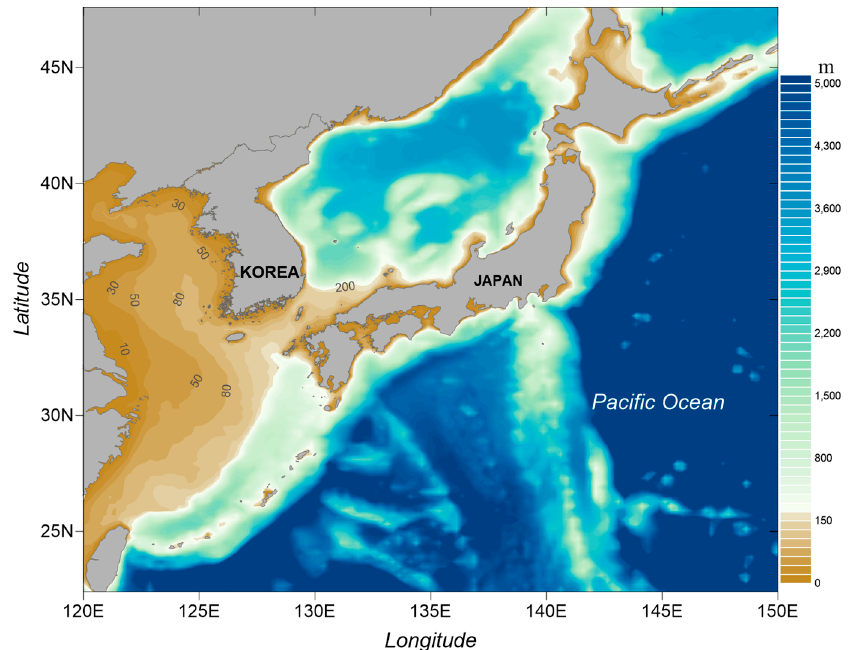
Figure 1. Locations of wave observation stations around Korean Peninsula provided by the Wave Information Network of Korea (WINK) system.